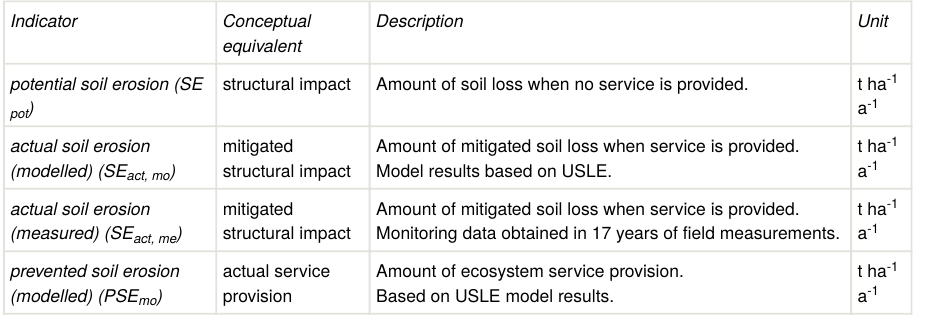
Indicators for soil erosion and ecosystem service